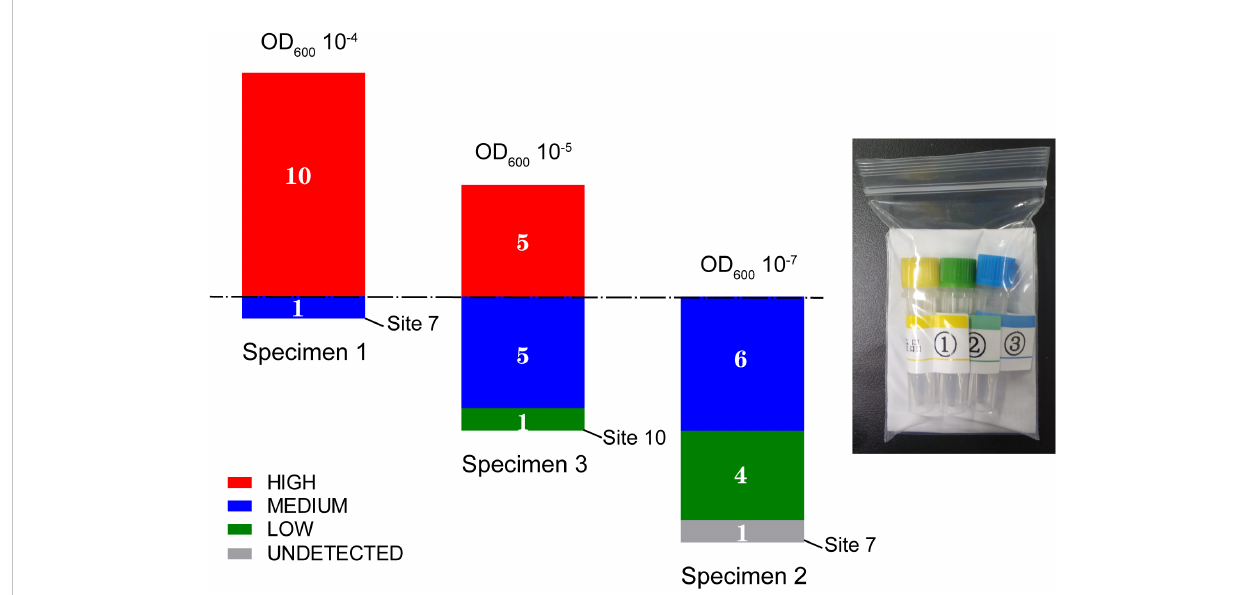
FIGURE 4 M. tuberculosis detection results of three specimens in the panel from the pilot survey in 11 clinical laboratories in